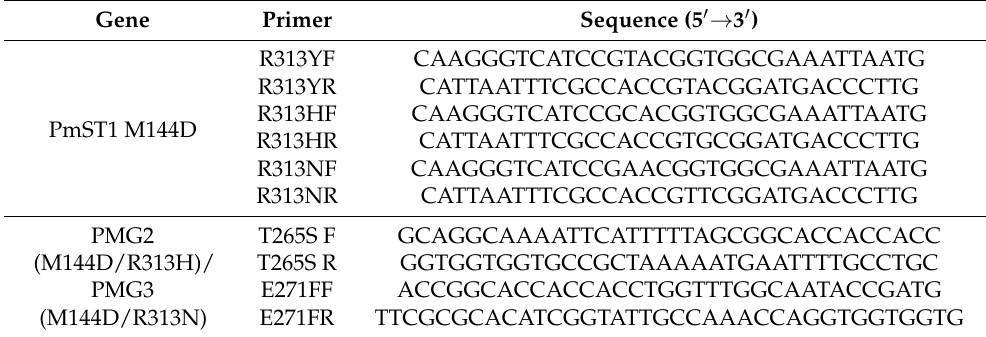
Table 5. Primer sequences for different site-directed